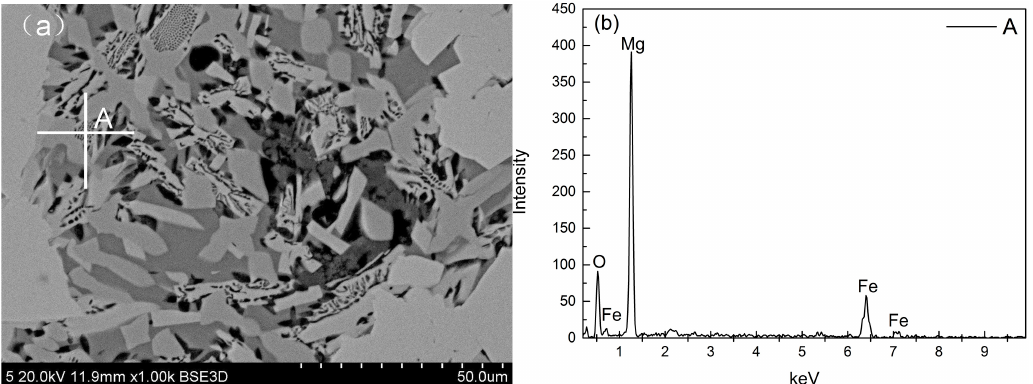
Figure 8. Magnesium ferrite and calcium ferrite bonding phases in the sinter ( ω (MgO) = 3.56%): ( a ) SEM micrographs; ( b ) EDS of point A.